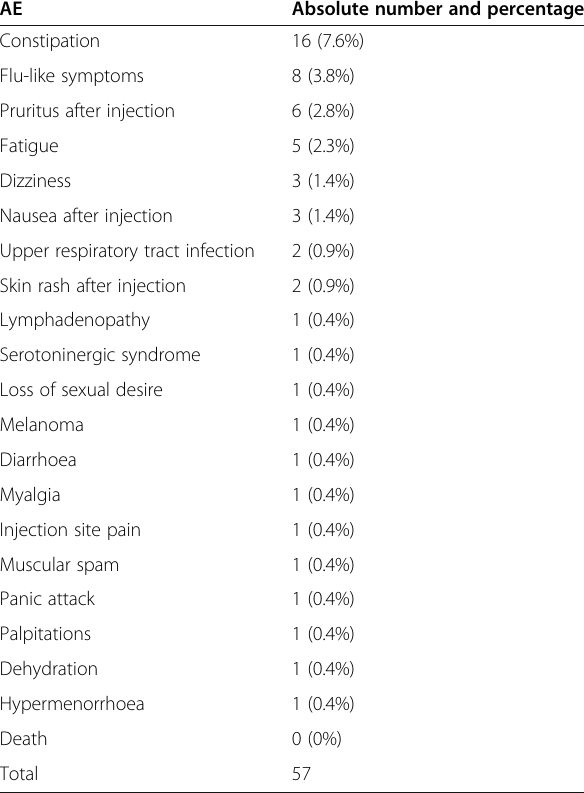
Table 3 Adverse events (AEs) collected during the 12 weeks